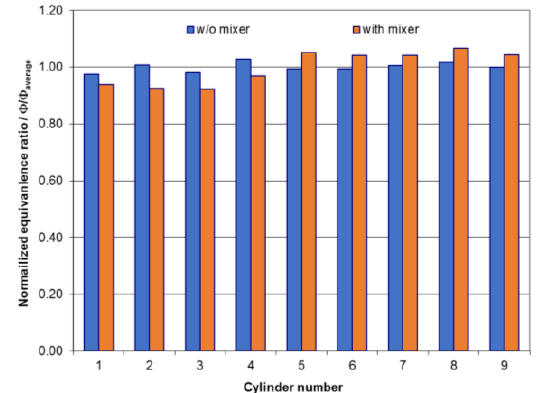
Fig. 1. Comparison of normalized equivalence ratio of two fuel system concepts for natural gas relevant flow conditions